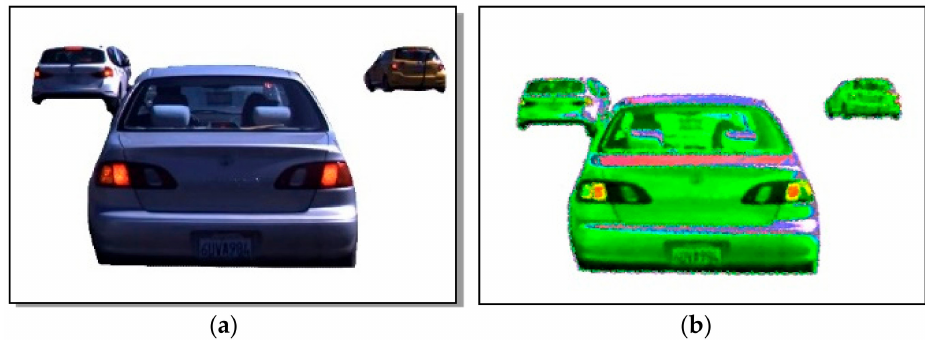
Figure 6. Example results of energy features: ( a ) background-subtracted image and ( b ) energy features.